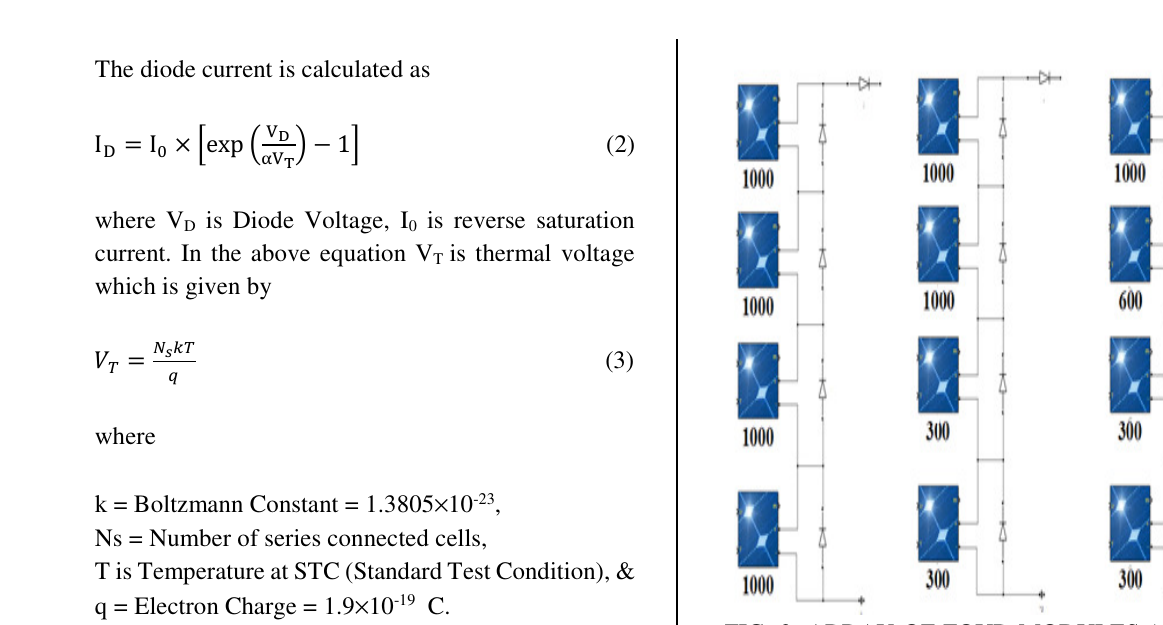
FIG. 2. ARRAY OF FOUR MODULES (4S) WITH SEPARATE TEST CASES CASE-1: NIL PARTIAL SHADING, CASE-2: WEAK PARTIAL SHADING, CASE-3: STRONG PARTIAL